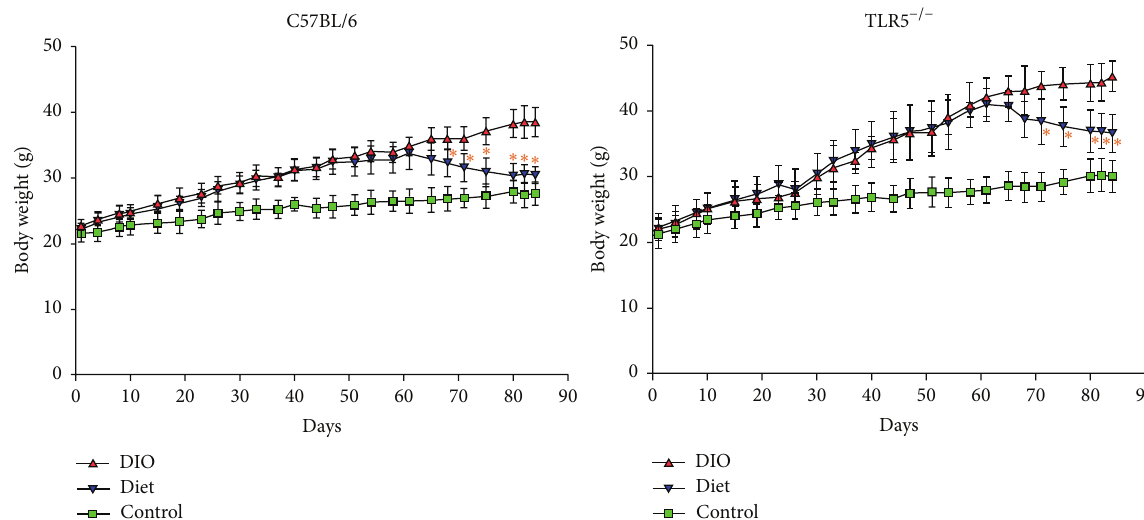
Figure 1: The body weight of C57BL/6 and TLR5 −/− mice on a weekly basis till week 12 ( 𝑛 = 8 ). Control: the mice fed with the standard diet; DIO: the mice fed with high-fat diet; diet: the mice fed with high-fat diet for 8 weeks to induce obesity and then we change to low-fat diet for subsequent 4 weeks. ∗ (red color), 𝑝 < 0.05 versus